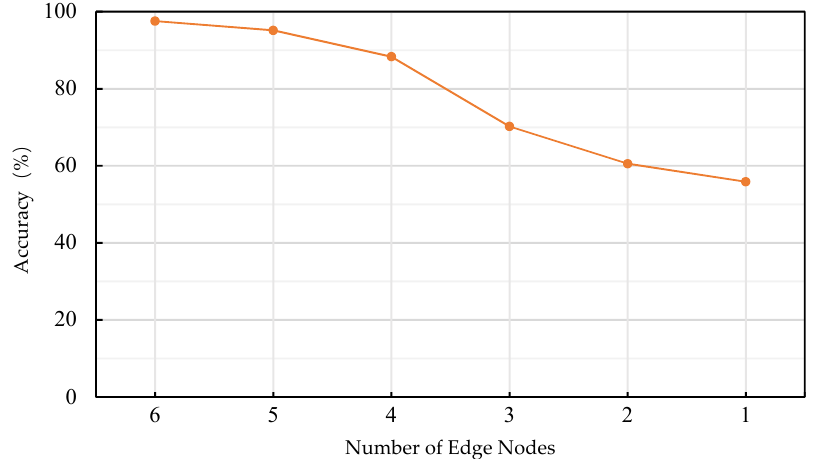
Figure 13. Variation in accuracy with the number of edge nodes.